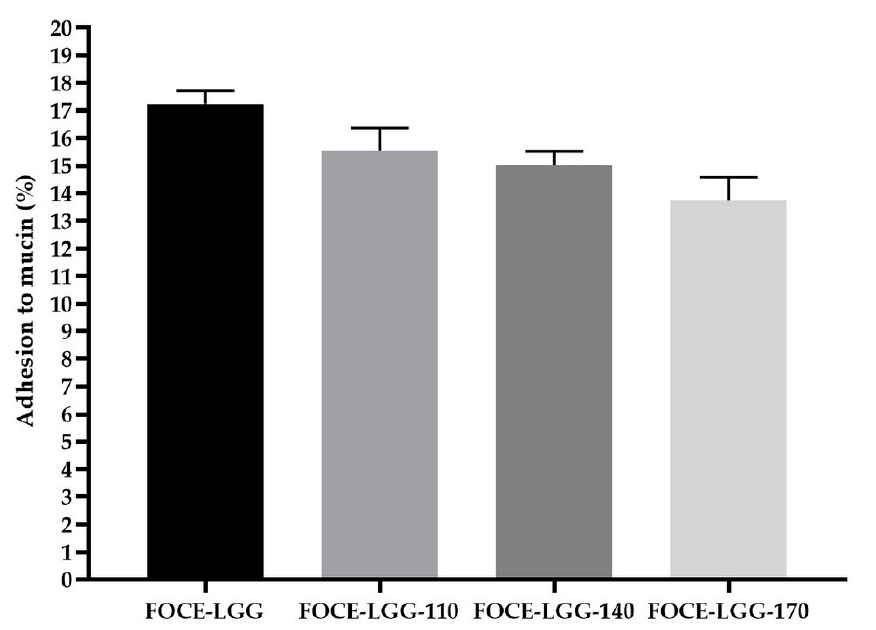
Figure 3. LGG adhesion to